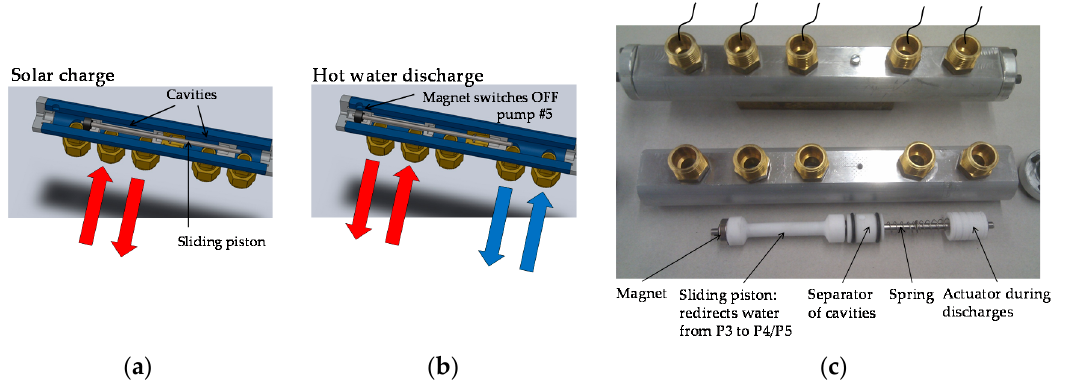
Figure 3. Newly developed multiport valve [27]: ( a ) during solar charge; ( b ) during hot water discharge; ( c ) picture of the components of the valve while dismounted.